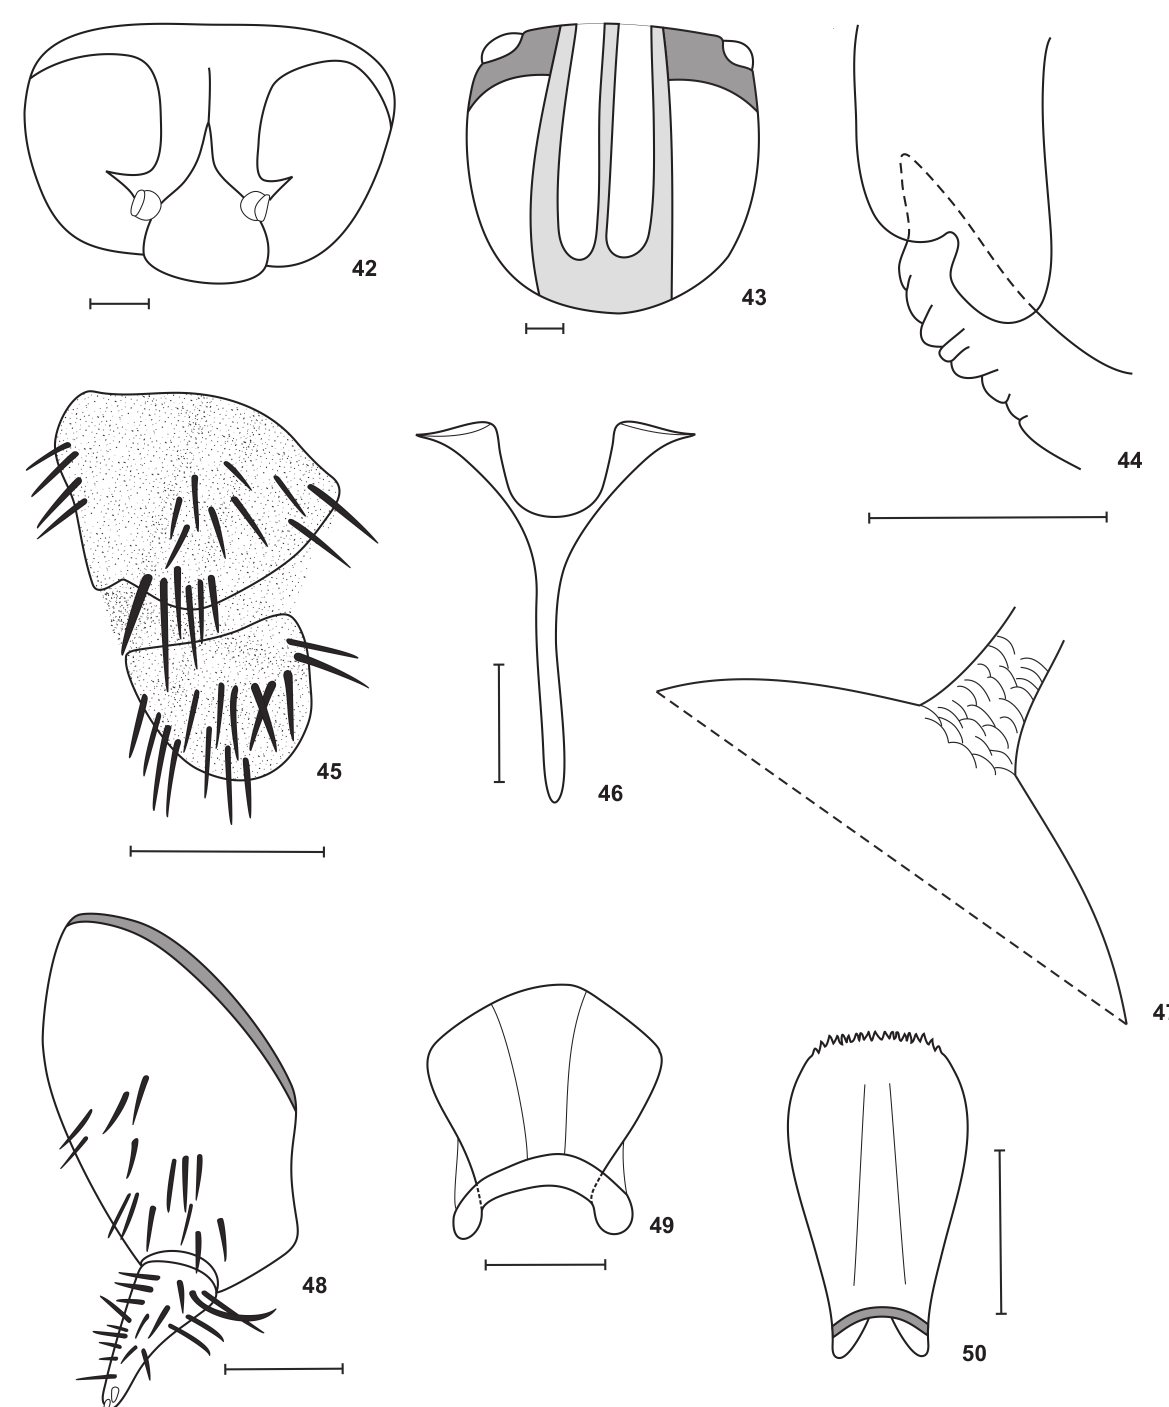
Figure 42-50. Adult of L. simplicicolor : (42-47 female) (42) head; (43) thorax; (44) calcipala and pedisulcus; (45) cerci and